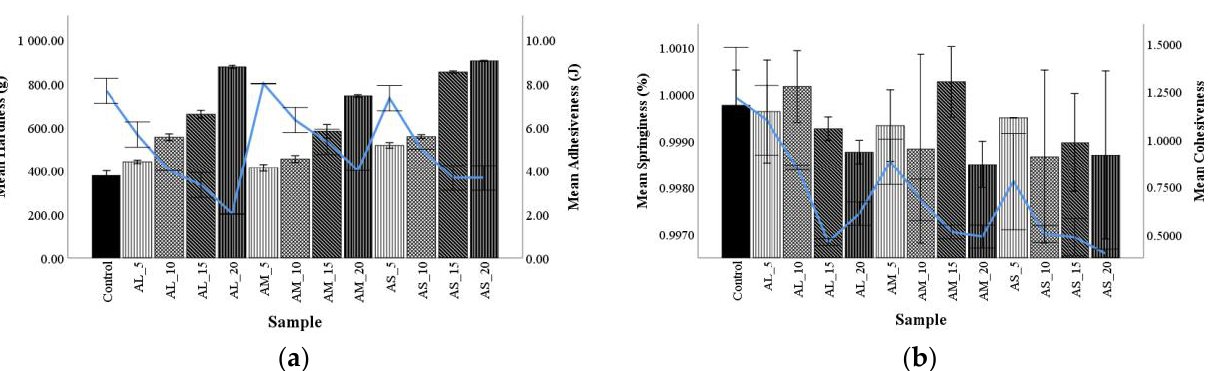
Figure 1. The effect of amaranth flour of large (AL), medium (AM), and small (AS) particle sizes added at 5%, 10%, 15%, and 20% on dough texture parameters: ( a ) hardness and adhesiveness and ( b ) springiness and cohesiveness compared with the